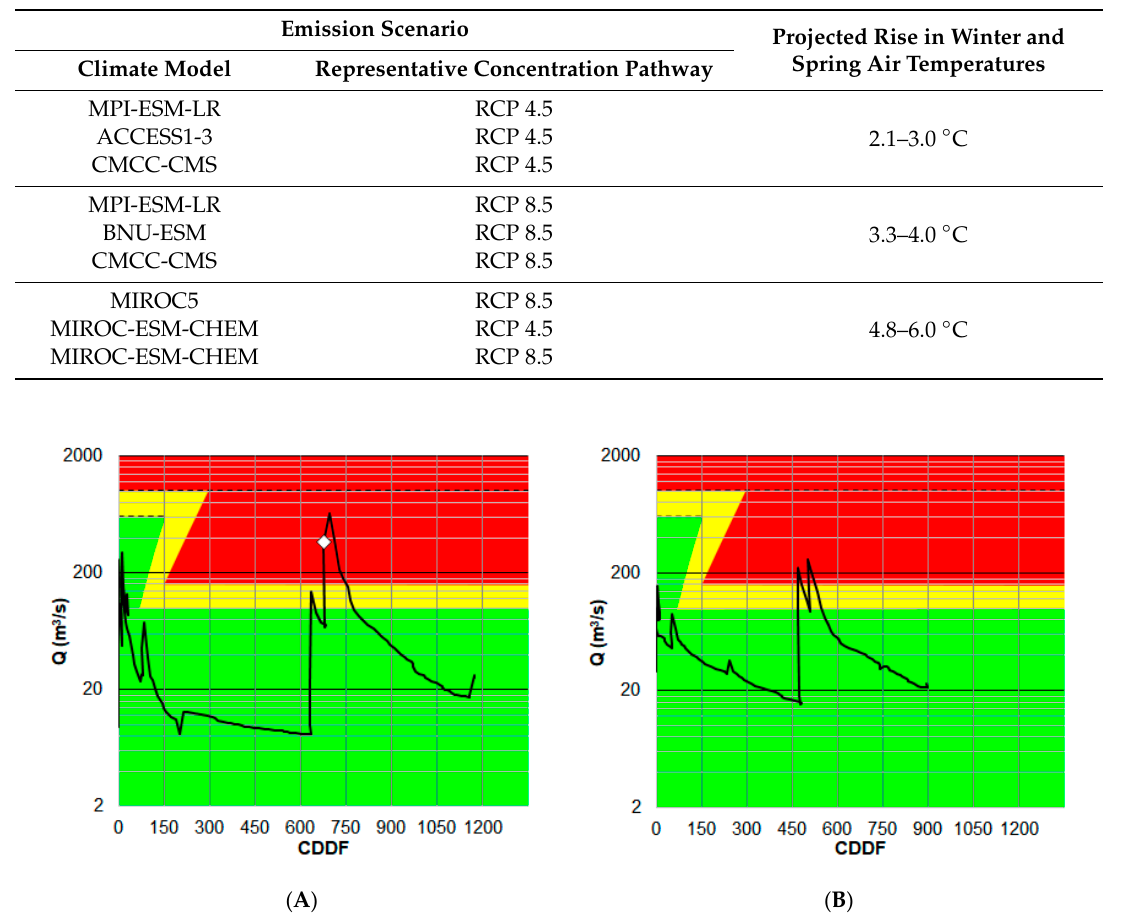
Figure 3. ( A ) Hydrometeorological data of winter 1985–1986 on the Chaudière River applied to the breakup model, including the reported ice jam of 27 January 1986 and ( B ) Data from the corresponding simulation of scenario MPI-ESM-LR RCP4.5 for winter 2055–2056.